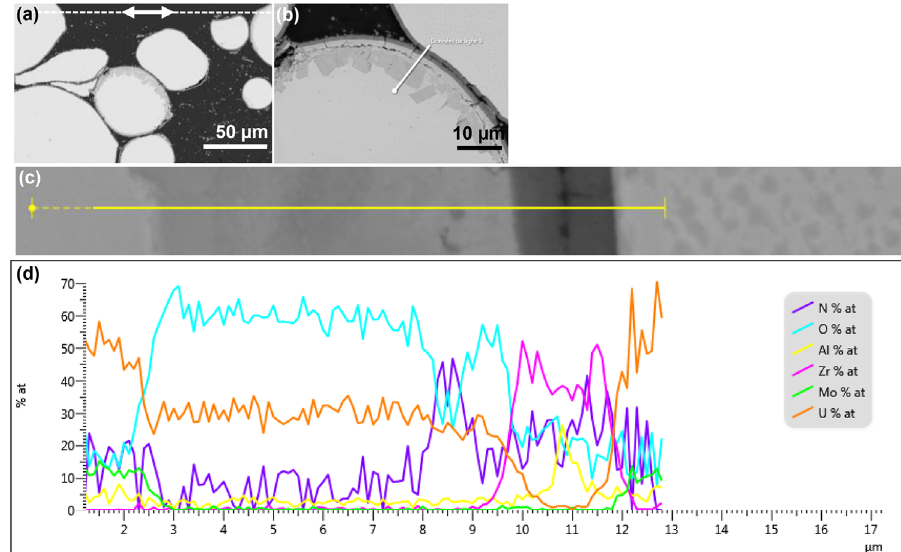
Fig. 6. SEM/EDS analysis of an oxidized U(Mo) particle in SF-202 plate (a) general view (white arrow: rolling direction (cid:3) dashed line: approximatepositionoffuel-claddinginterface),(b)and(c)locationoftheanalysisline,(d)EDSpro fi